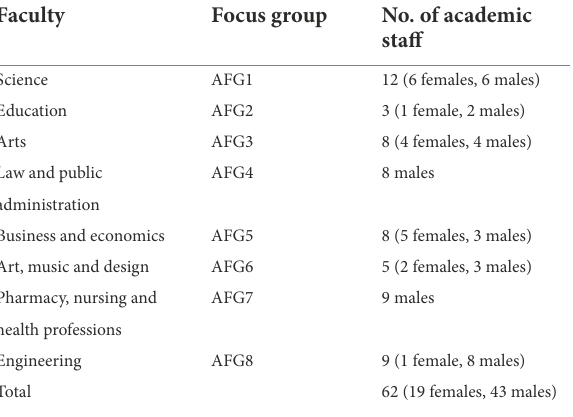
TABLE 1 Distribution of faculty members on the focus group